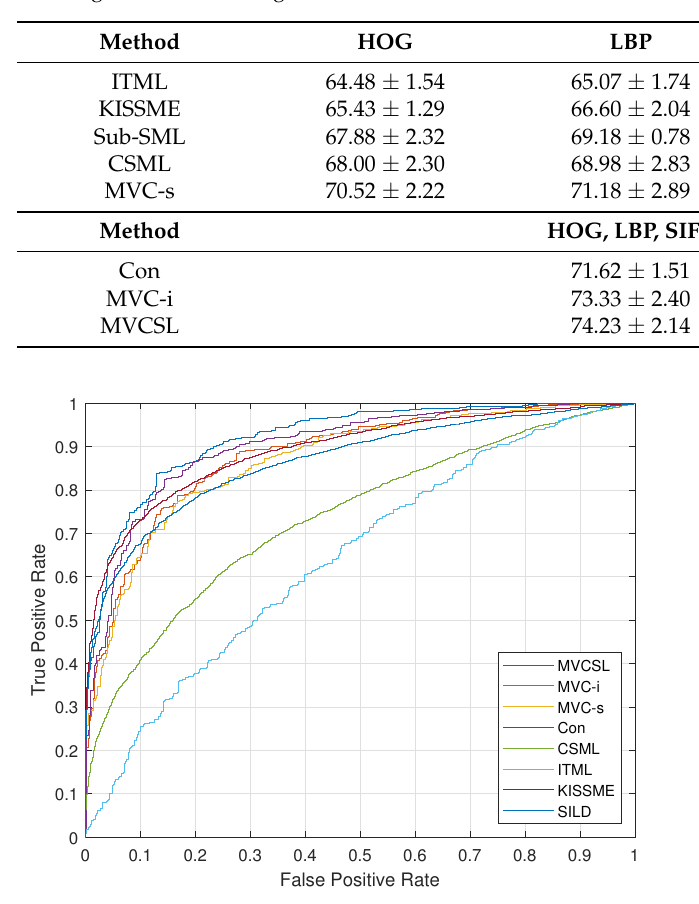
Table 2. Mean accuracy and standard error (%) of different methods on the FGLFW dataset under the image restricted setting.